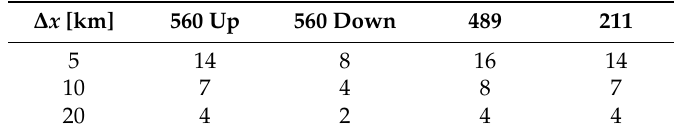
Table 2. Number of stretches identified for each swath based on the length of the discretization, ∆ x . ∆ x [km] 560 Up 560 Down 489 211 5 14 8 16 14